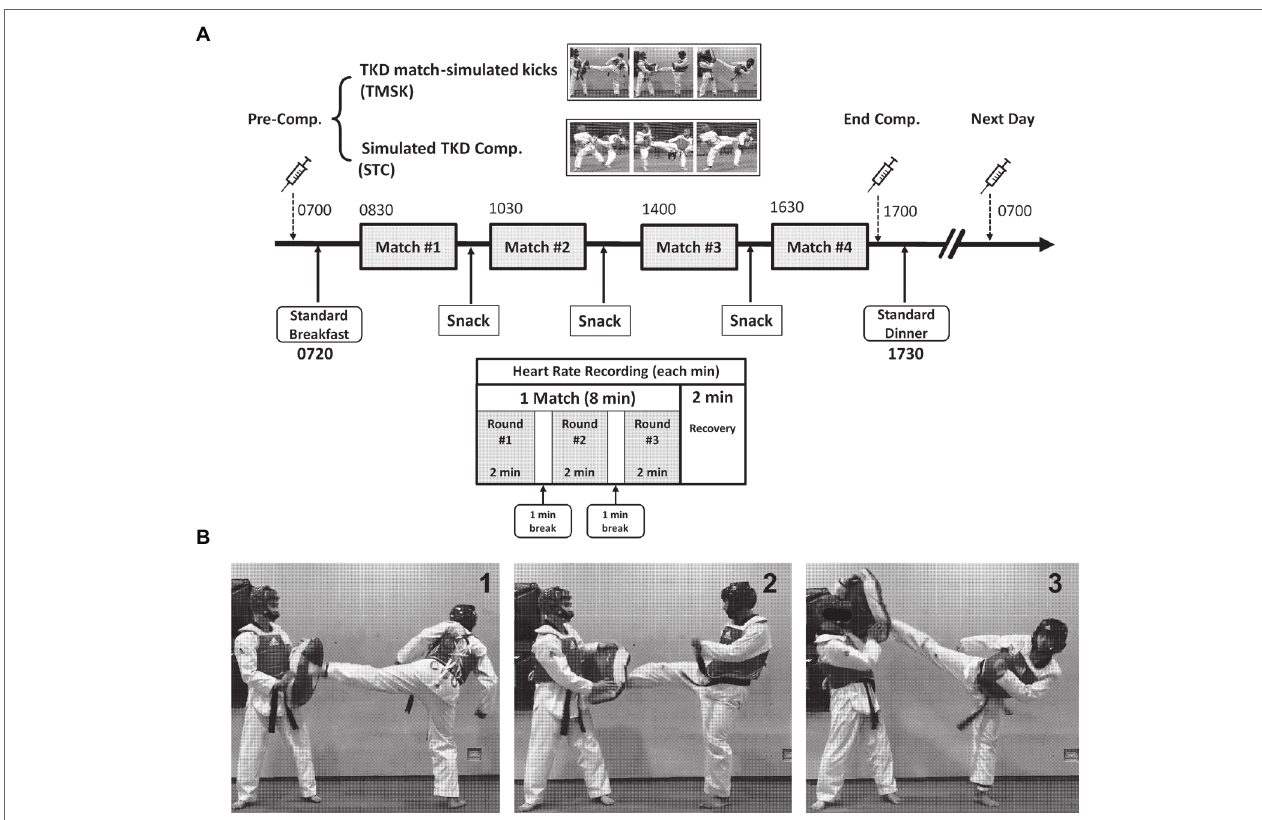
FIGURE 1 | Experiment design and procedure of match in accordance with current Olympic TKD competition time frame. (A) Four consecutive combat matches were performed at 8:30, 10:30, 14:00, and 16:30. The blood samples were drawn before matches (7:00), after the completion of the last match (17:00), and on Next day (07:00; 24 h after the first match). (B) Three different kicks were used in the intermittent interval exercise (10-s kicking with full effort and 10-s bouncing jumping break) in the present study, and the movements used to reconstruct real TKD competition during the TMSK, including (1) sidekick, (2) reverse side kick, and (3) roundhouse kick. The individuals in this manuscript gave written informed consent to use and publish these image details. TMSK: TKD-match simulated kicks; STC: simulated TKD